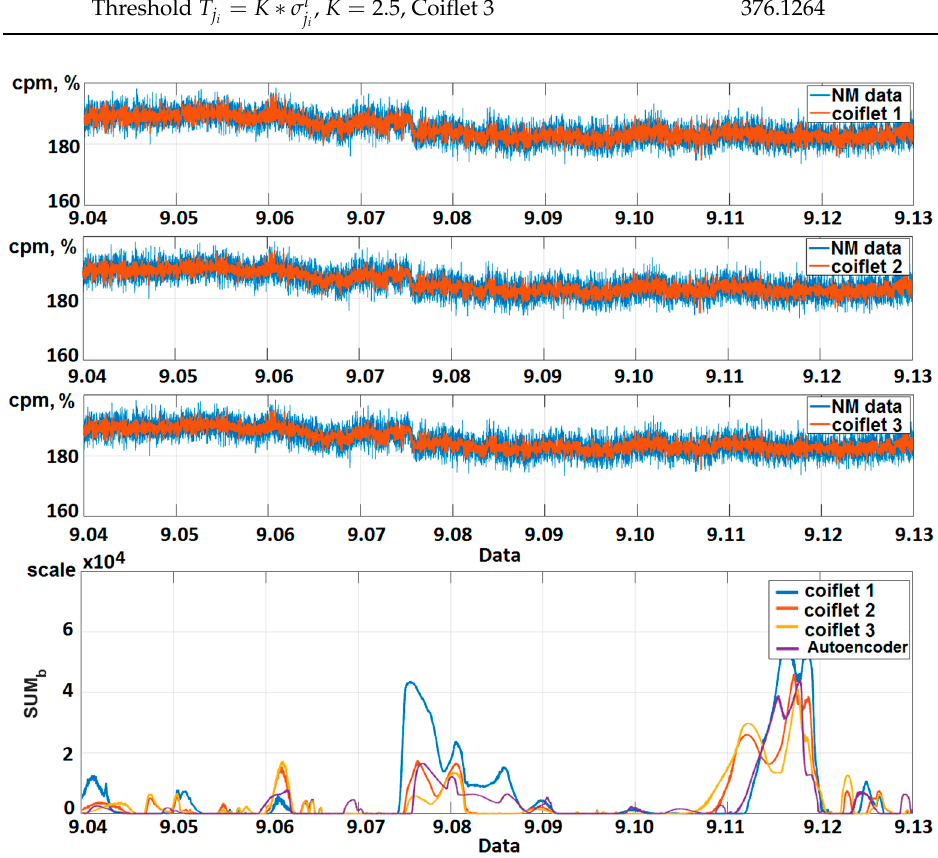
(cid:3039) . = 2.5 ∗ σ l = 2,5 ∗ 𝜎 (cid:3037) (cid:3284) j i i (cid:3284)